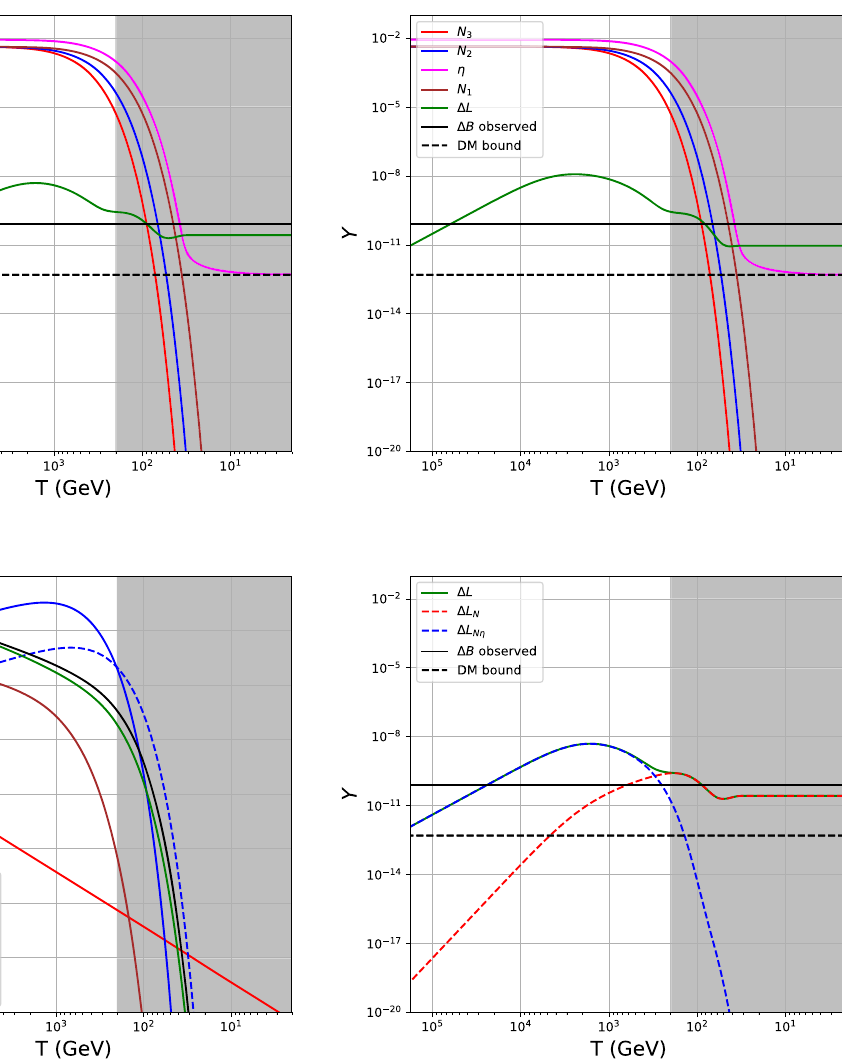
(co)annihilation contributions of each channel to the asymmetry. The solid (dashed) black line corresponds to the baryon asymmetry (DM abundance) observed at present epoch ( T ∼ 0). Shaded regions repre- sent the epochs after sphaleron freeze